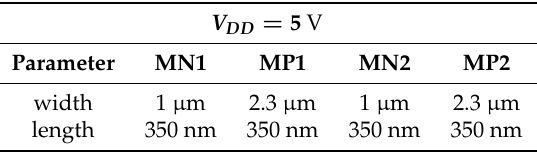
Table 1. MOSFET Parameters for simulations in